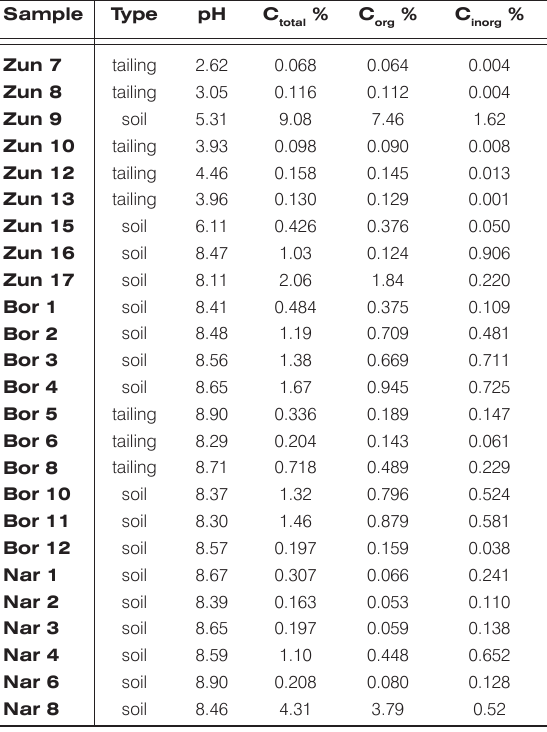
Table 1. Sample characterization.